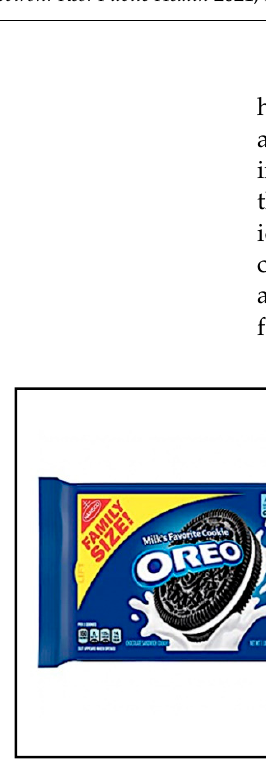
Figure 1. Nutritional Labels of Food Products.